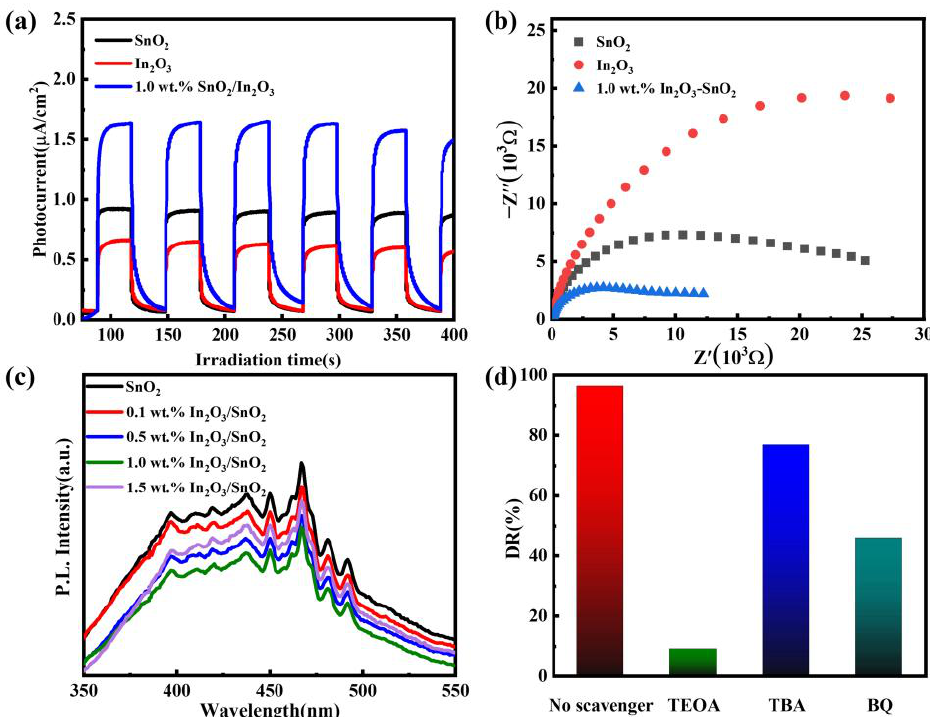
Figure 7. Photoelectrochemical characterization: ( a ) photocurrent of the samples; ( b ) EIS of the samples; ( c ) PL spectra of different samples; and ( d ) degradation of RhB with the addition of BQ, EDTA, TBA.